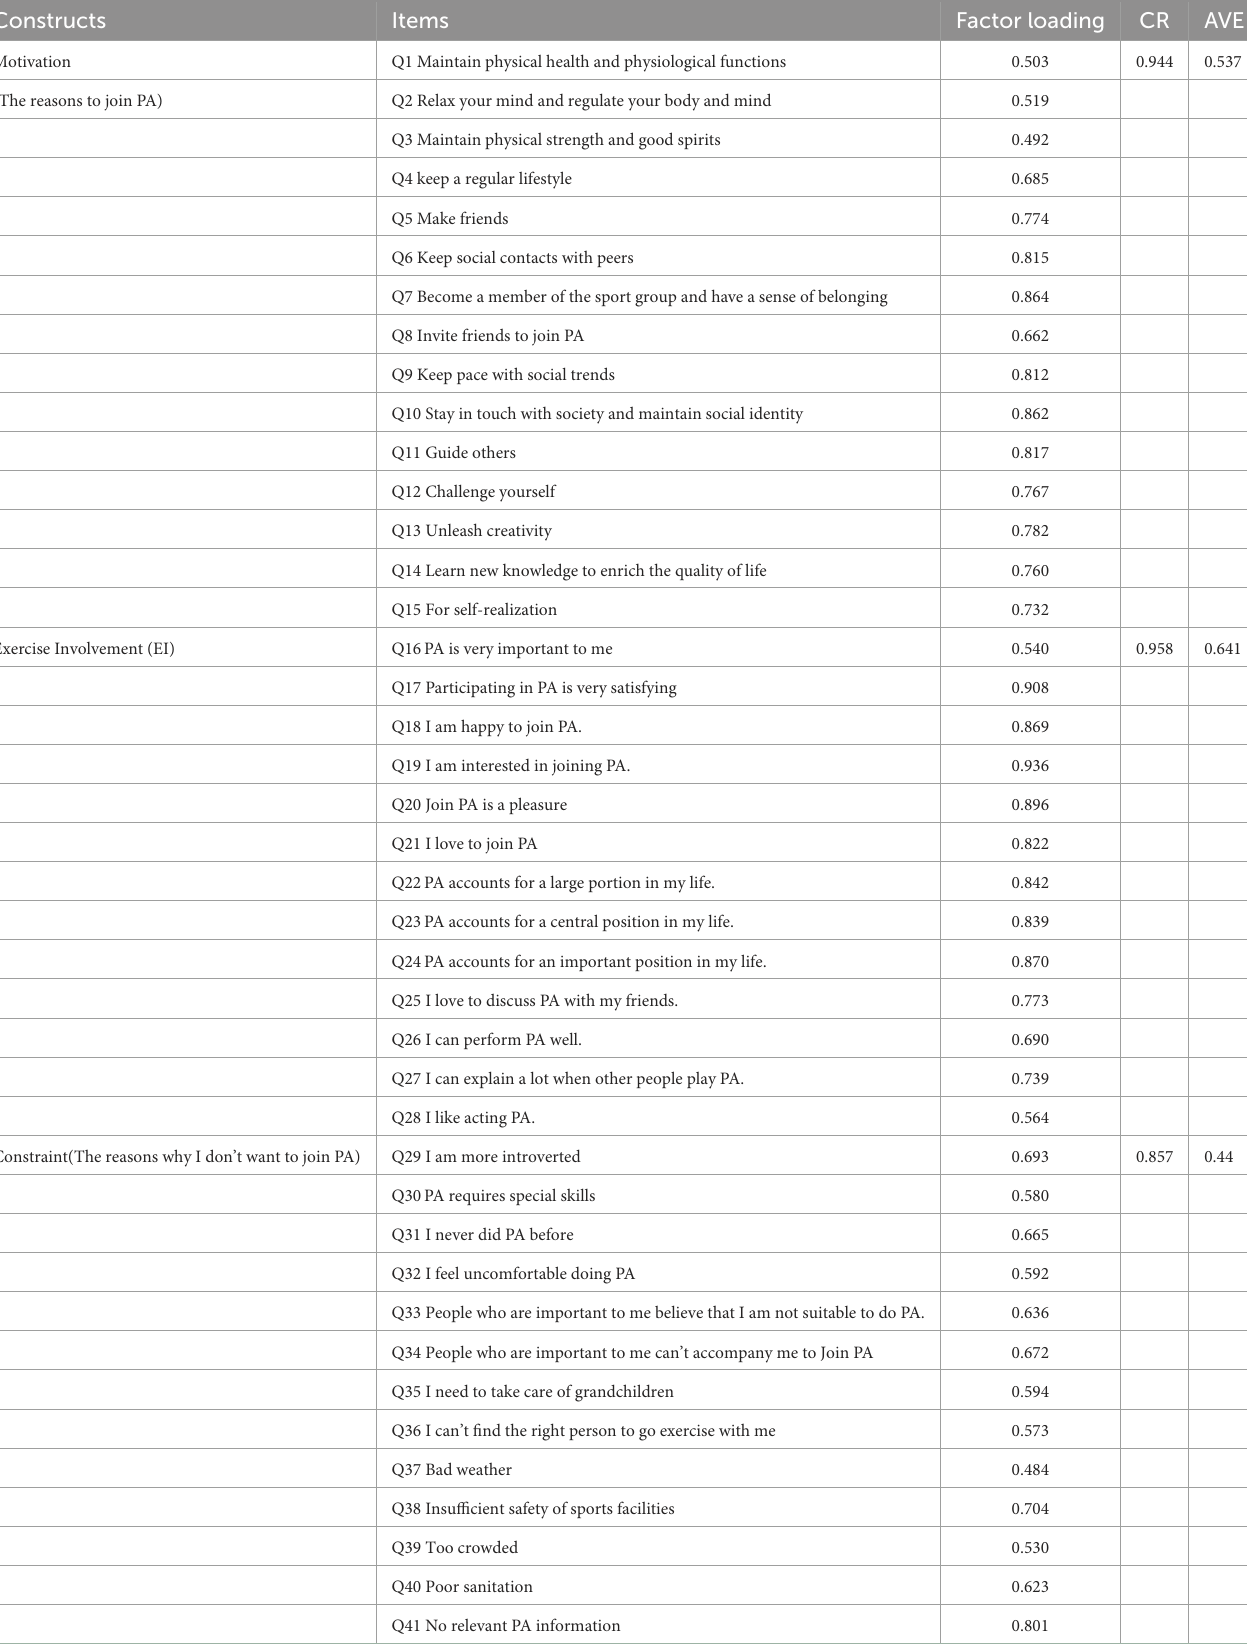
TABLE 2 Major related extant research on